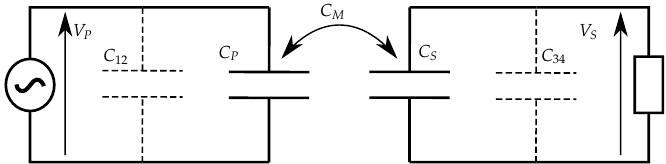
Figure 5. Representation of the capacitive coupling